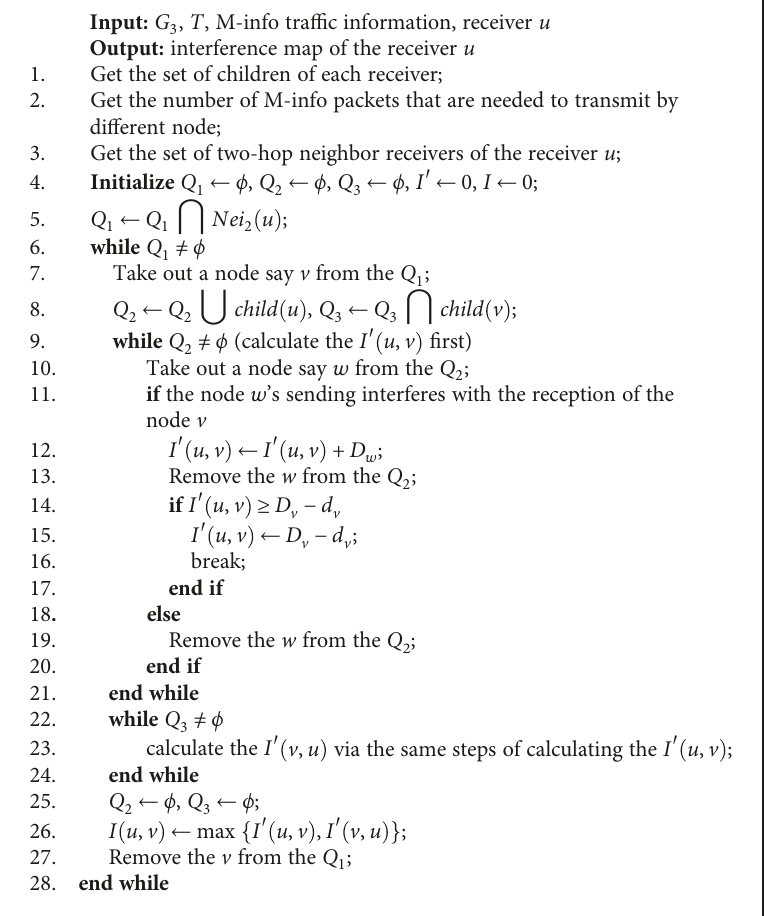
Algorithm 4: Interference map